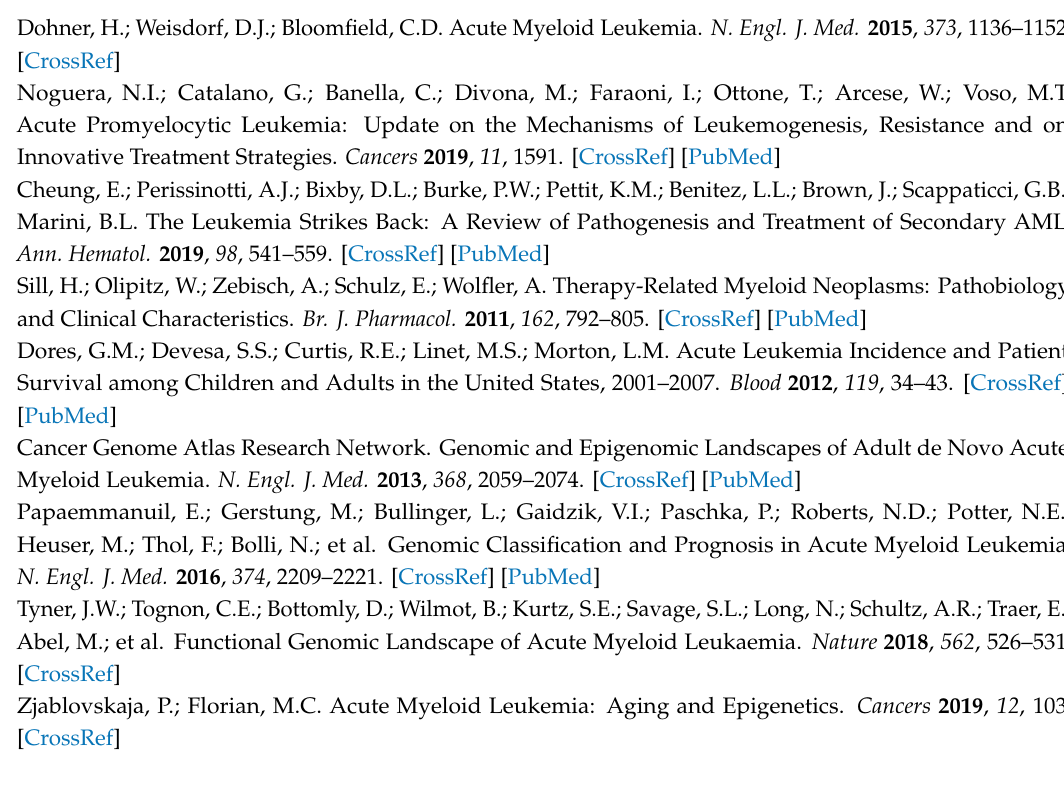
Table S1: Median event-free survival rates of AMLSG patients with and without TP53-mutated AML and with respect to TP53 functional scoring systems; Table S2: Cox proportional hazards regression analysis of the e ff ect of di ff erent functional mutation scoring systems and patient characteristics on overall survival—univariate analysis; Table S3: Cox proportional hazards regression analysis of the e ff ect of di ff erent functional mutation scoring systems and patient characteristics on event-free survival—univariate analysis; Table S4: Sensitivity and specificity values of the various thresholds for the EAp53 score and the “Relative Fitness Score” (RFS); Figure S1: Event-free survival probabilities for patients with TP53 -mutated AML according to functional mutation scoring systems; Figure S2: Overall and event-free survival probabilities for patients with TP53 -mutated AML according to the RFS with a cut-o ff set at − 1; Figure S3: Receiver operating characteristics analysis for the “Relative Fitness Score” as a predictor for 1-year mortality; Figure S4: Boxplots of the “EAp53 score” and the “Relative Fitness Score” for patients with TP53 -mutated AML according to the survival status at 1